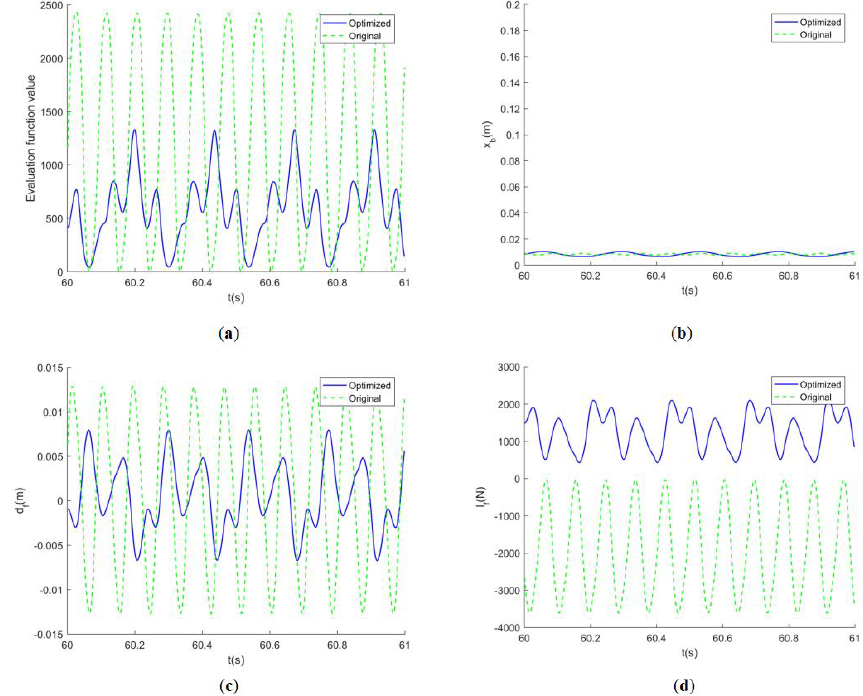
Figure 8. Comparison of system response curves of each parameter of the semi-active suspension vehicle before and after optimization. (a) Objective function F . (b) The vehicle body’s vertical displacement. (c) The front suspension’s dynamic deflection. (d) The front wheel’s dynamic